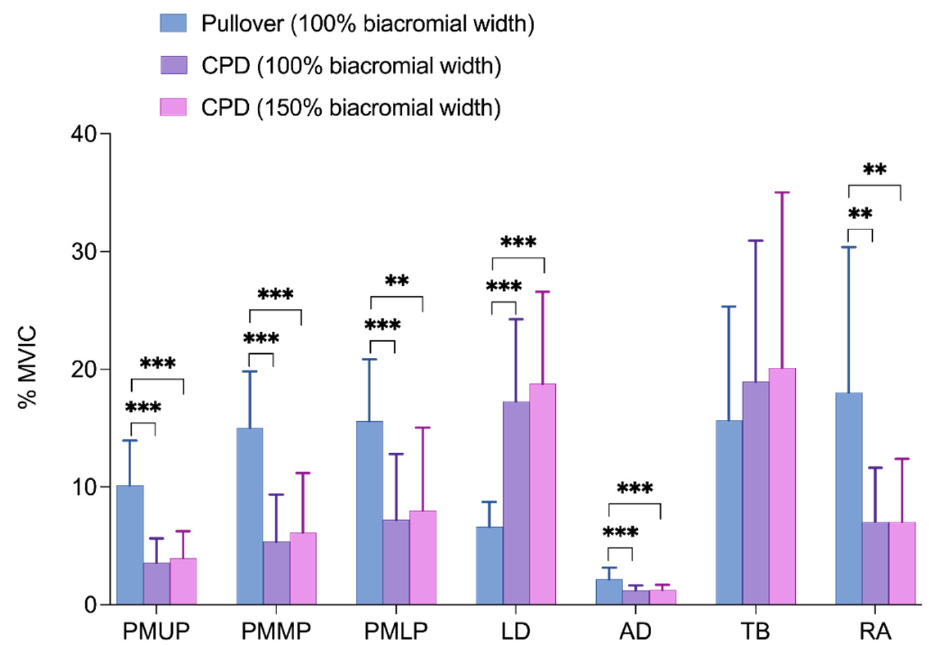
Figure 2. Comparison of the EMG activity among the evaluated exercises: pullover and straight arm pulldown (expressed in %MVIC). PMUP—pectoralis major upper portion; PMMP—pectoralis major middle portion; PMLP—pectoralis major lower portion; LD—latissimus dorsi; AD—anterior deltoid; TB—